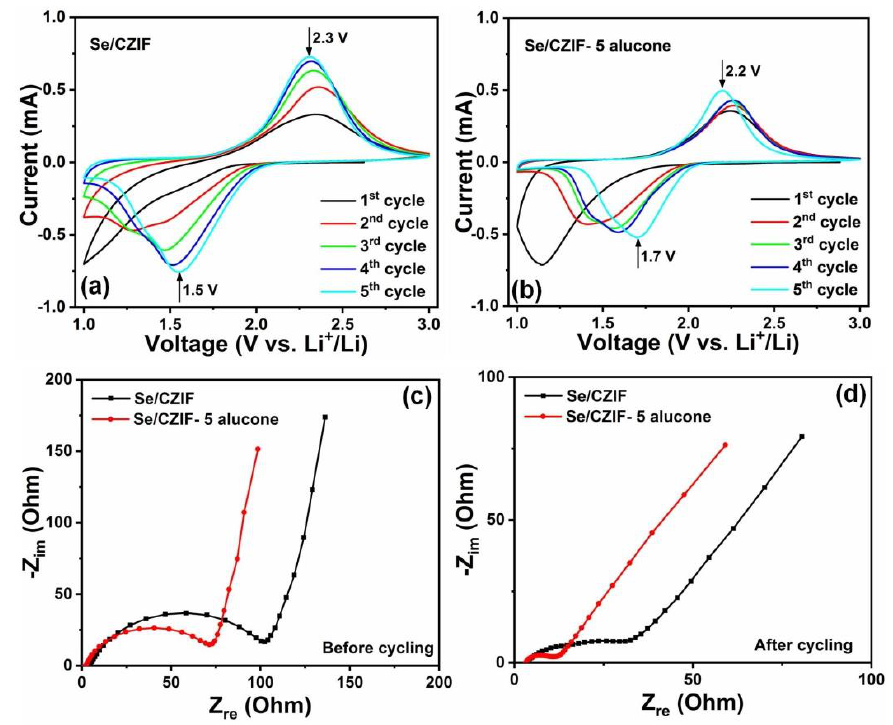
Figure 4. CV curves of the first 5 cycles for ( a ) Se/CZIF and ( b ) Se/CZIF − 5 alucone, EIS curves of Se/CZIF and Se/CZIF − 5 alucone for ( c ) before ( d ) after cycling.